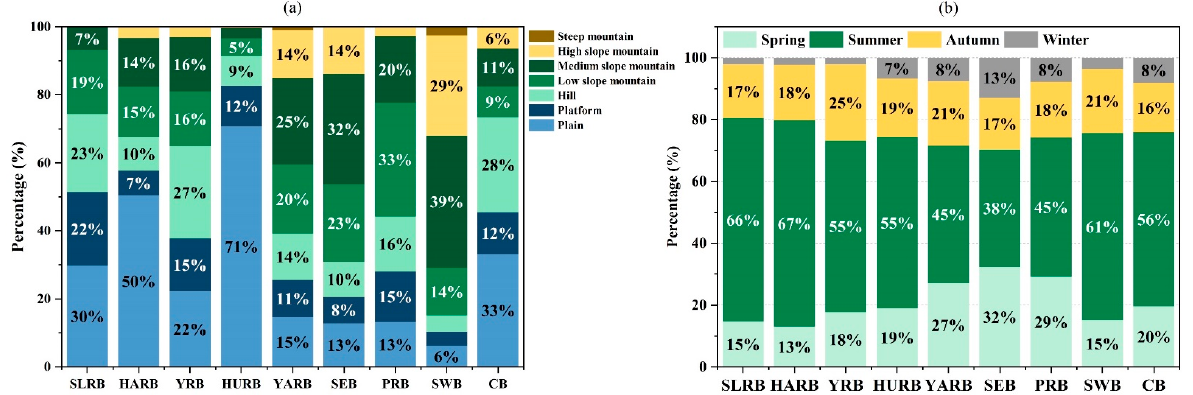
Figure 9. The proportion of topography ( a ) and seasonal precipitation ( b ) in different river basins. The proportion of seasonal precipitation in annual precipitation.